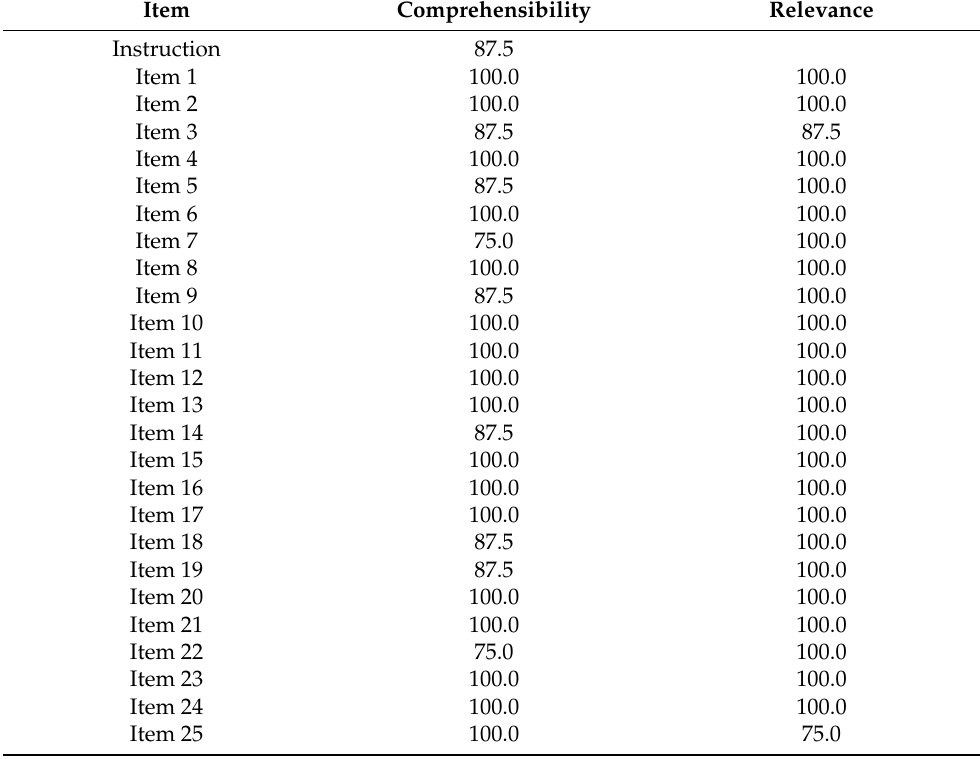
Table A4. The percentage of agreement of comprehensibility and relevance through